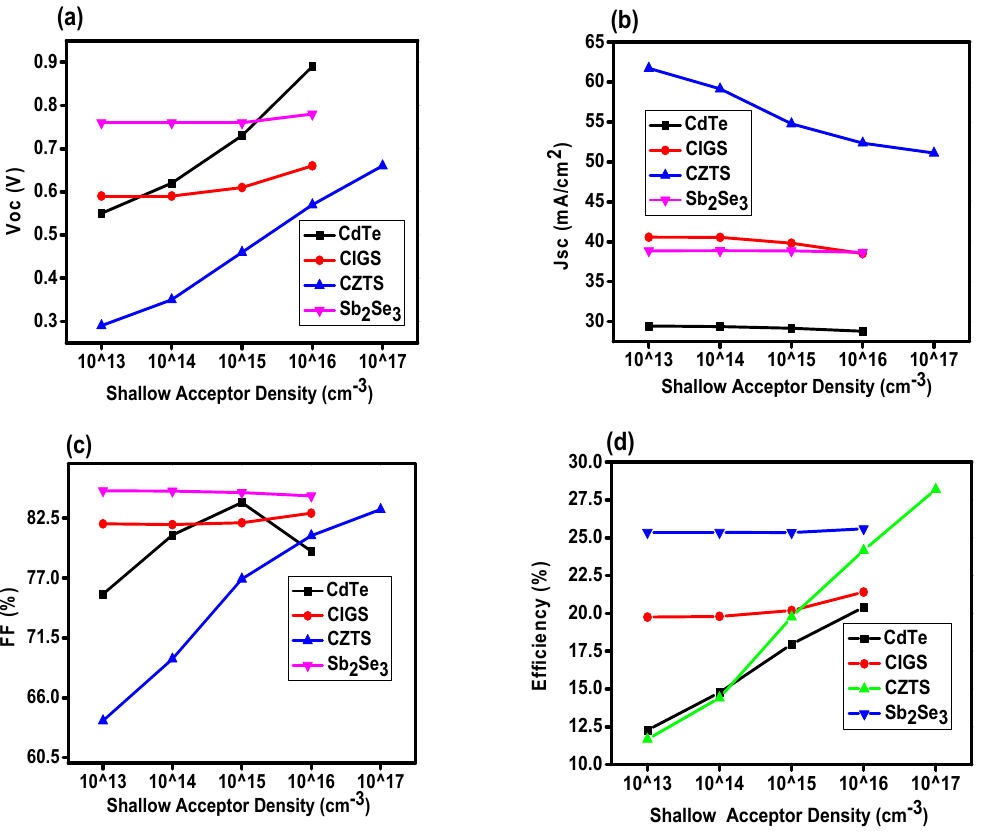
Figure 3. Impact of acceptor density of various absorber layers on ( a ) Voc, ( b ) Jsc, ( c ) FF, and ( d )